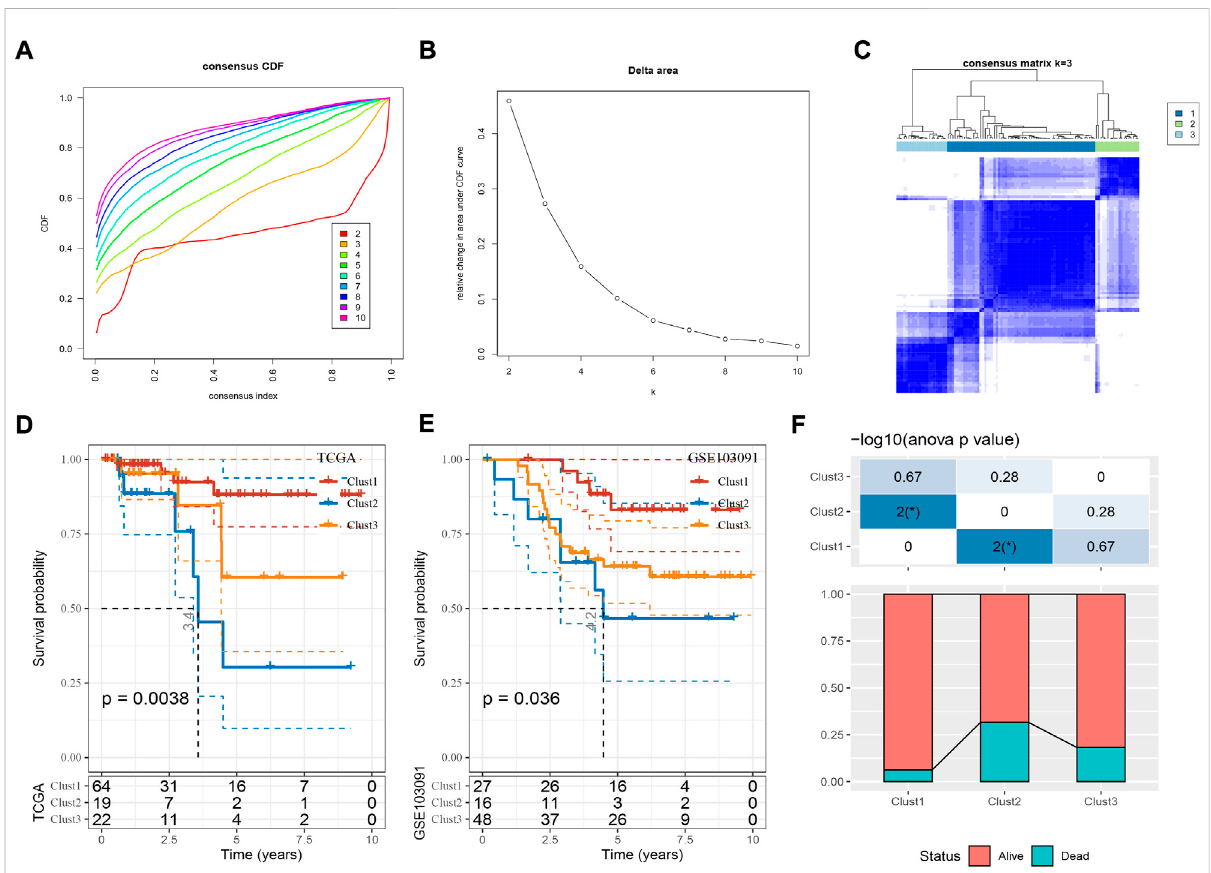
FIGURE 2 Constructionofmolecularsubtypesbasedoncuproptosis-associatedgenes. (A,B) ConsensusCDFcurveanddeltaareaunderCDFcurvewhen cluster number k = 2 to 10. (C) Consensus matrix when k = 3. (D,E) Kaplan-Meier survival curve of three molecular subtypes in TCGA (D) and GSE103091 (E) datasets. Log-rank test was performed. (F) The distribution of alive and dead samples in three subtypes. ANOVA was conducted. * p <